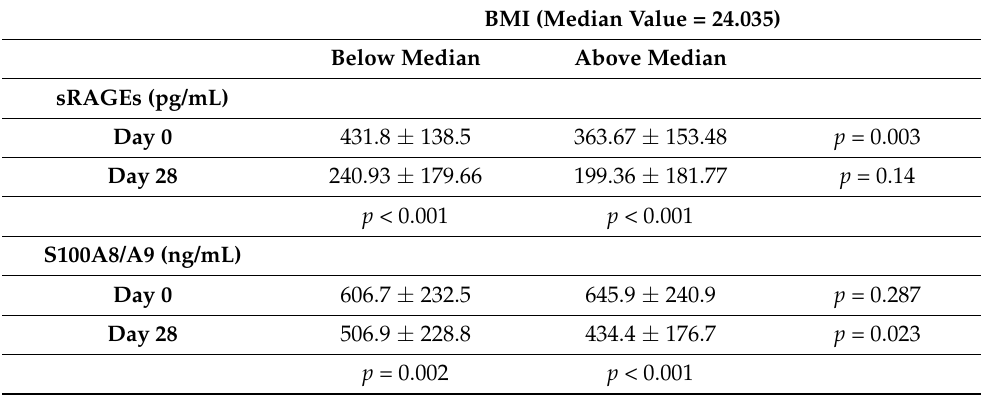
Figure 3. Line charts with biomarkers’ changes across BMI categories for S100A8/A9. ( A ), * p < 0.001 vs. baseline; sRAGE ( B ), * p < 0.001 vs. baseline, ** p < 0.005 vs. baseline. BMI Categories ac- cording to WHO Classification: <18.5 underweight, 18.5-25 normal weight, 25-30 overweight, >30 obese.